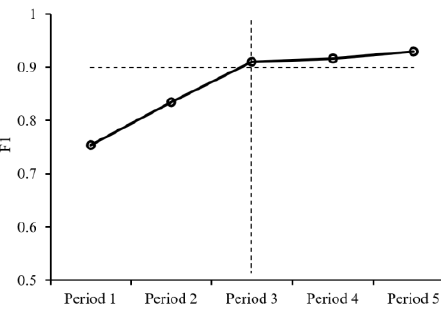
8 of 15 Figure 4. Separability results of classification metrics. 3.2. Earliest Identifiable Phenophase Determination As the length of the time series of the input classification metrics continually in- creased, F1 kept increasing, as shown in Figure 5. The time series of input classifiers were processed as described in Section 2.3.3. The F1 obtained from three synthetic images of